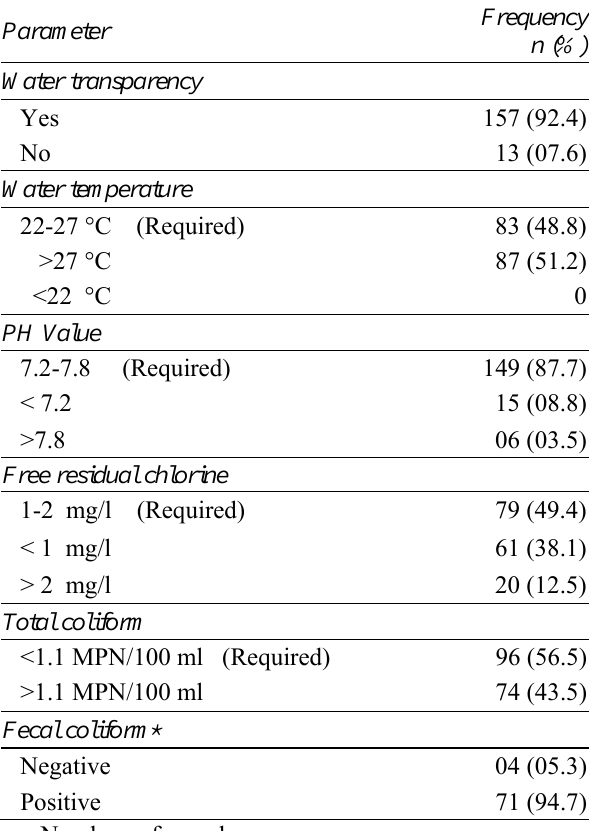
Table 2: Public Swimming Pools Sanitary